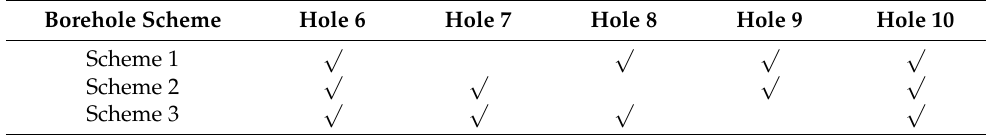
Table 2. Different borehole schemes considered in the